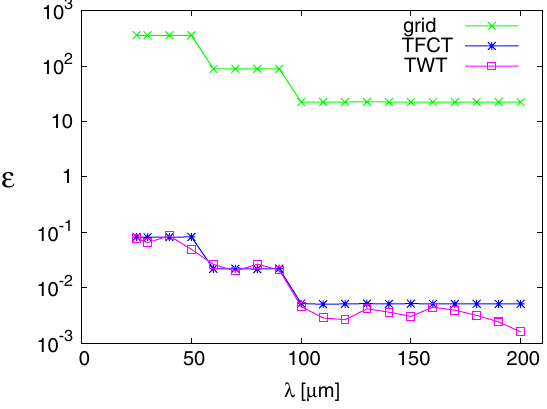
FIG. 12. Accuracy of the 3rd-order z derivative of the modu- lated flattop particle distribution (measured by the IMSE) for the three gridded approximations: grid (green); FCTon a grid (blue); and grid with wavelet denoising, using Daubechies wavelets of order 10 (purple). The parameters are given in Table III.